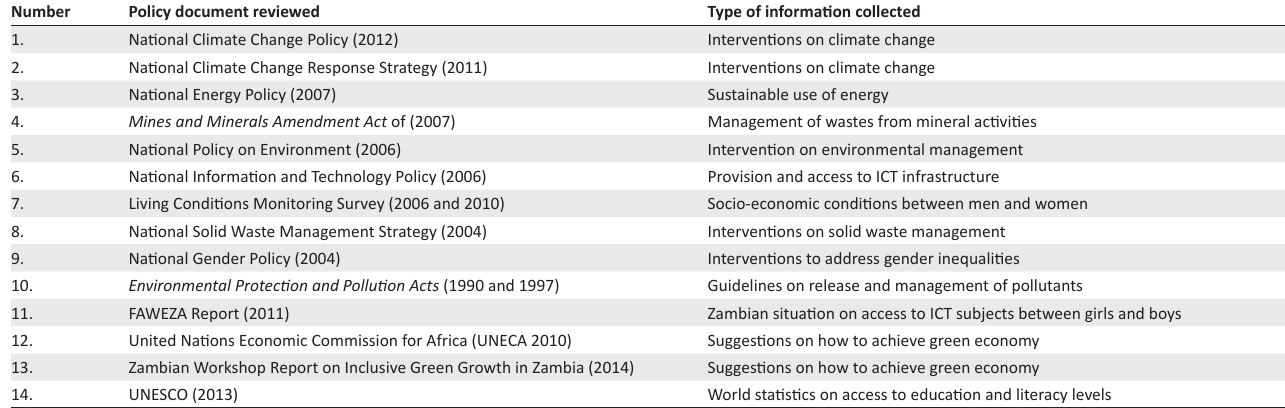
TABLE 1: Reviewed policy